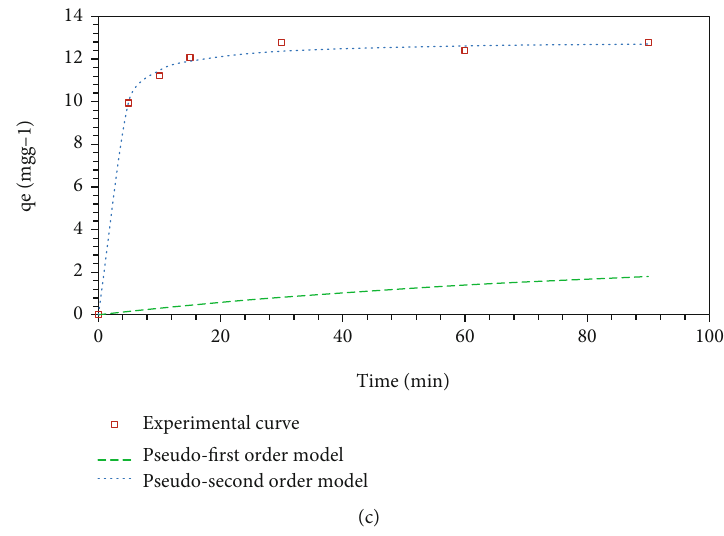
Figure 13: Plots of (a) pseudo- fi rst-order kinetic, (b) pseudo-second-order kinetic, (c) and experimental